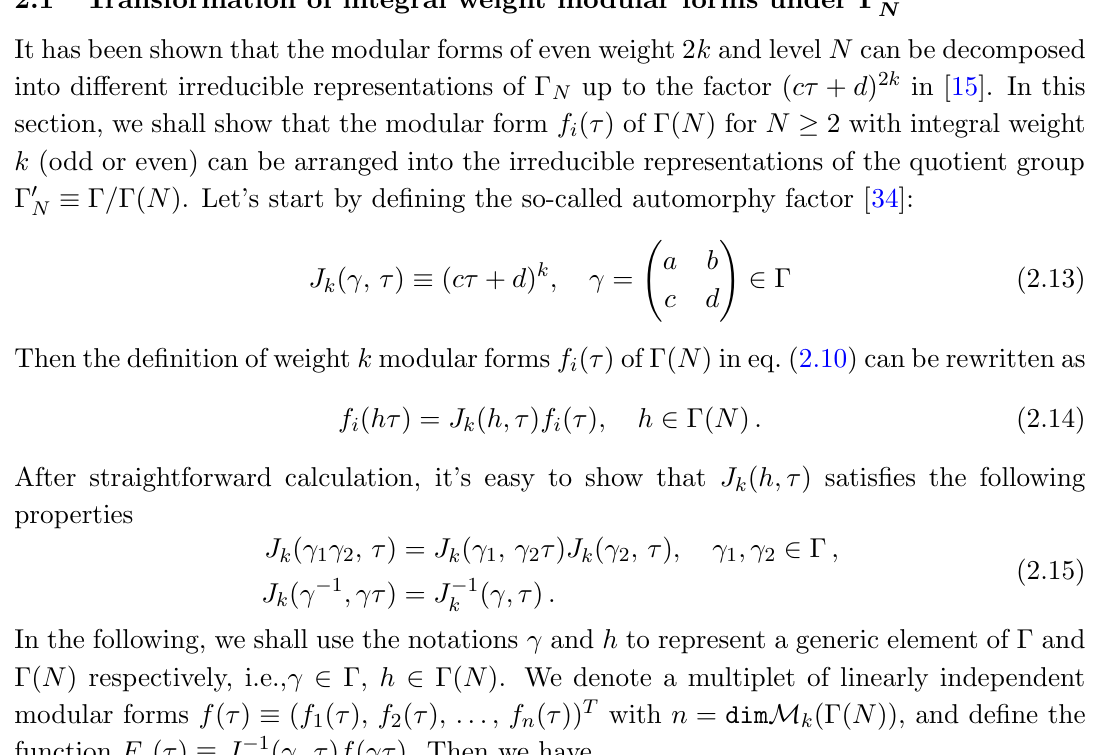
and (cid:0) 0 as S 0 and A 0 respectively. The 4 5 4 5